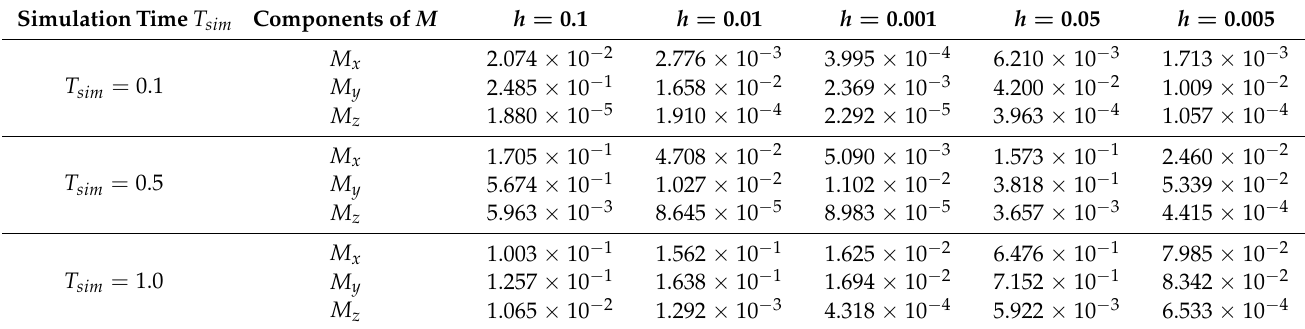
Table 1. Average absolute error in the New Iterative Predictor-Corrector Algorithm (NIPCA). Simulation Time T sim Components of M h =